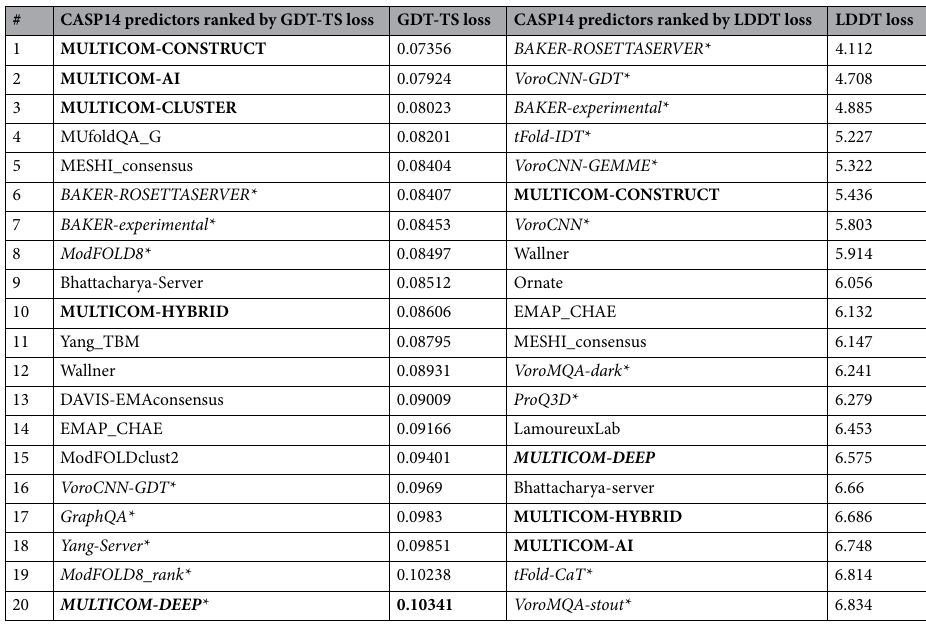
Table 3. Top 20 CASP14 EMA Predictors ranked by GDT-TS loss and LDDT Loss, respectively. Here, the original, official GDT-TS loss of each predictor is normalized into the range [0, 1]. Bold font stands for MULTICOM predictors. * and Italic font denote the single-model methods.